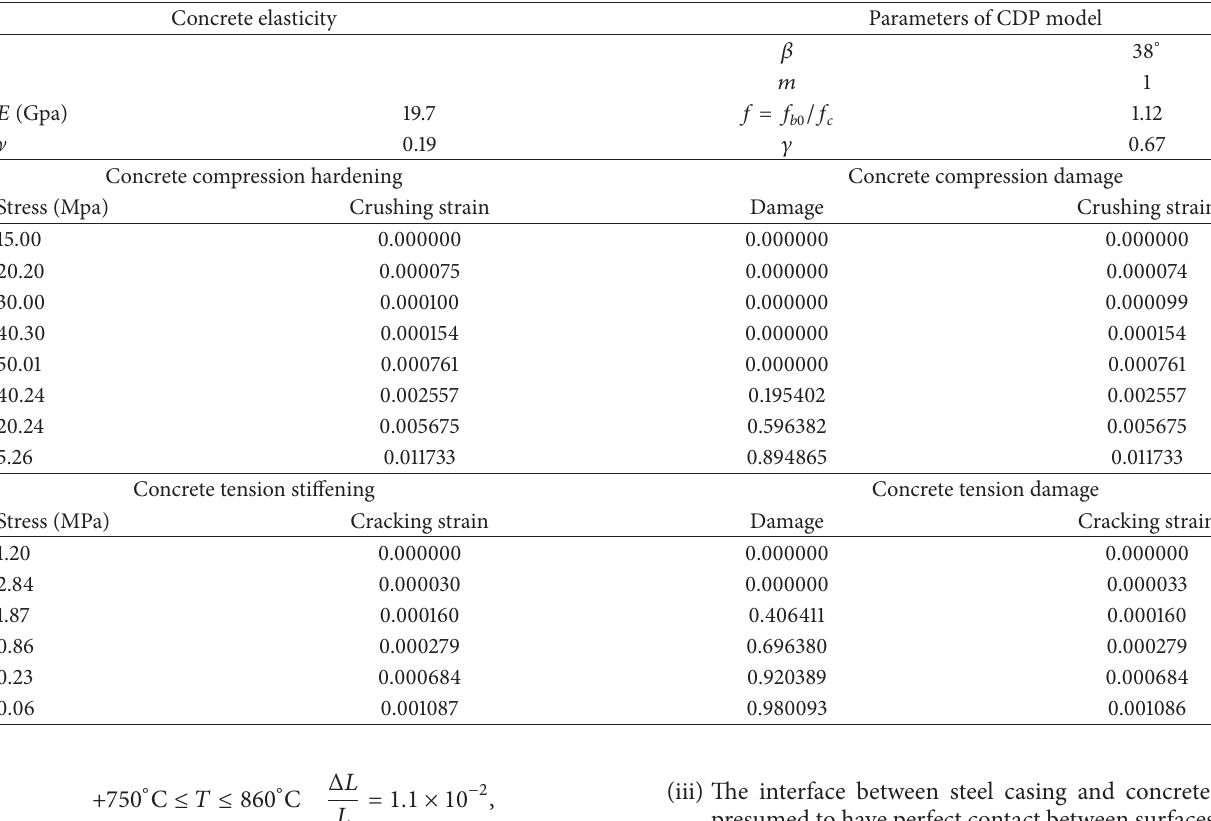
Table 1: Material parameters of CDP model for concrete